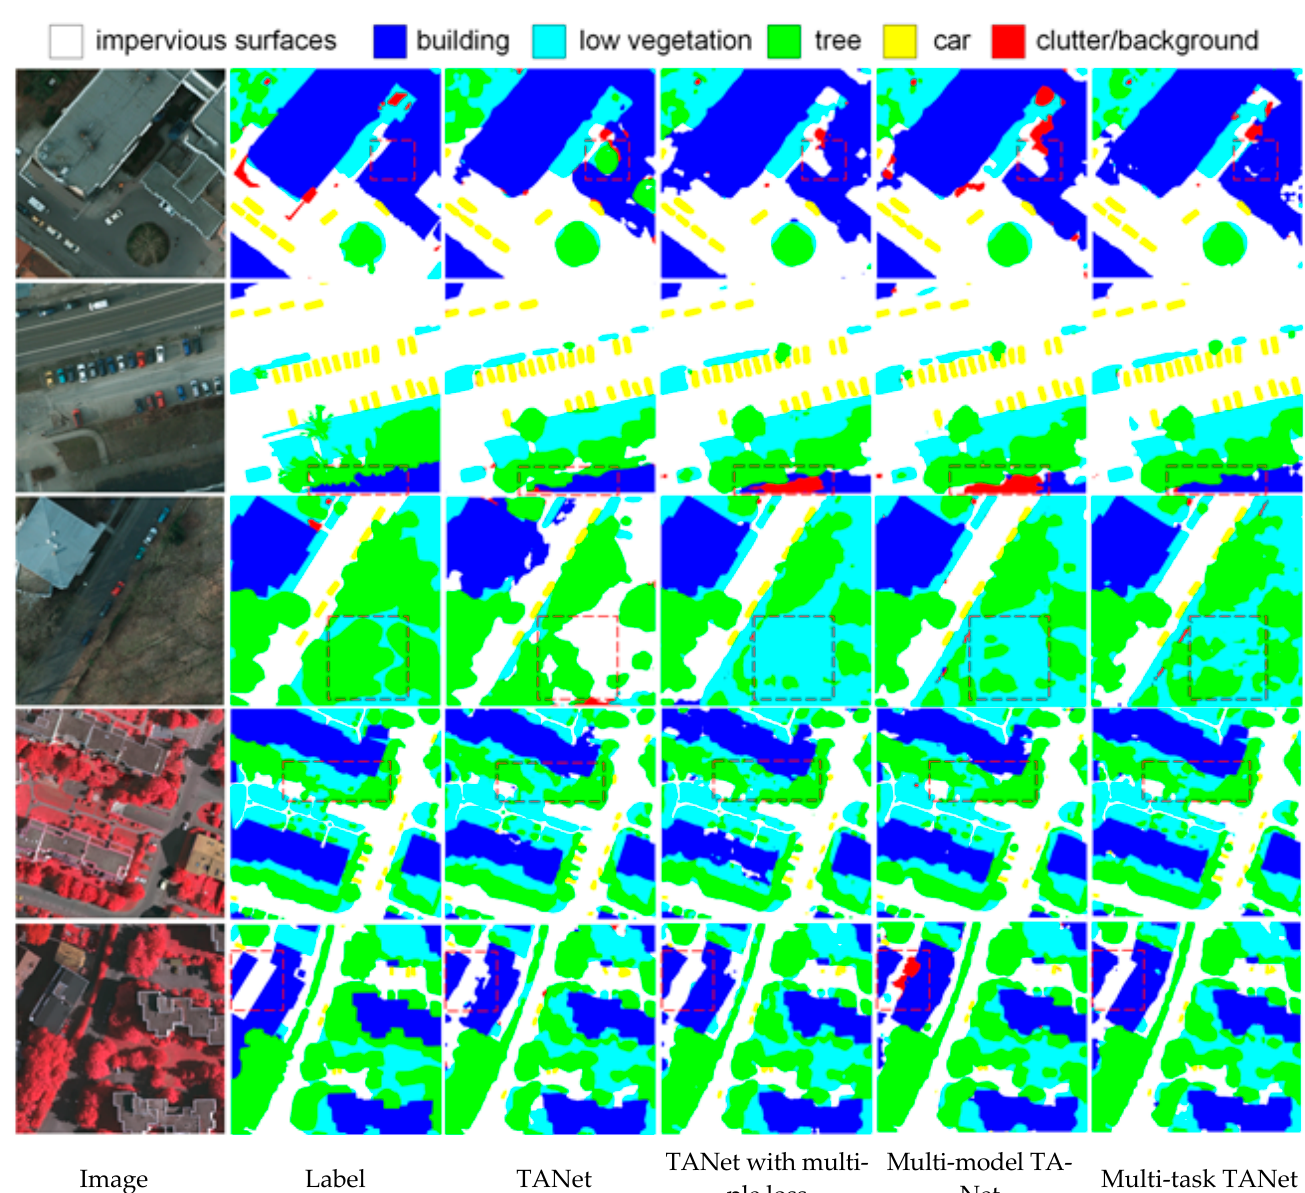
Figure 11. Examples of semantic segmentation results on ablation study of multi-task learning. The first three rows are from the Potsdam dataset and the others are from the Vaihingen dataset.